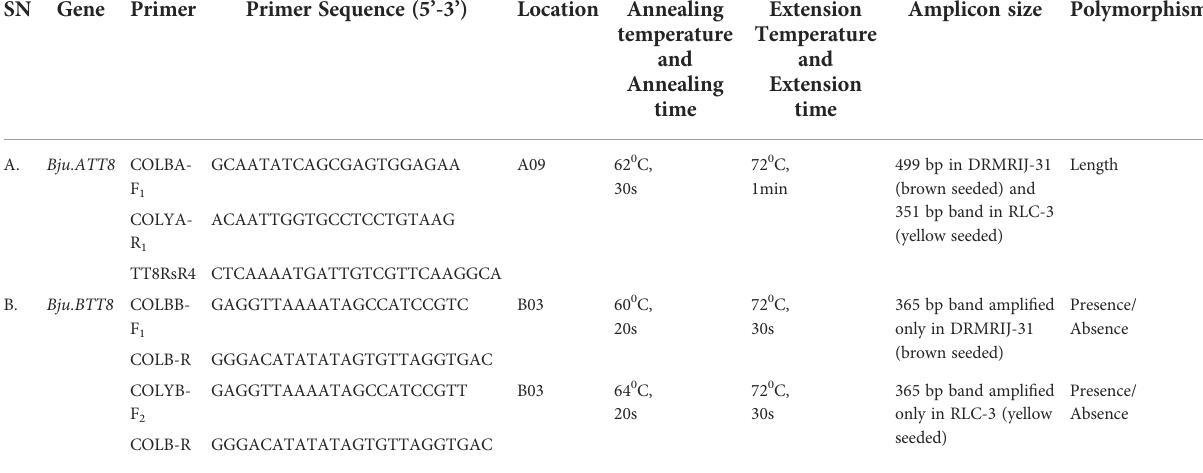
TABLE 2 Details of primers used for the development of functional markers for Bju.TT8